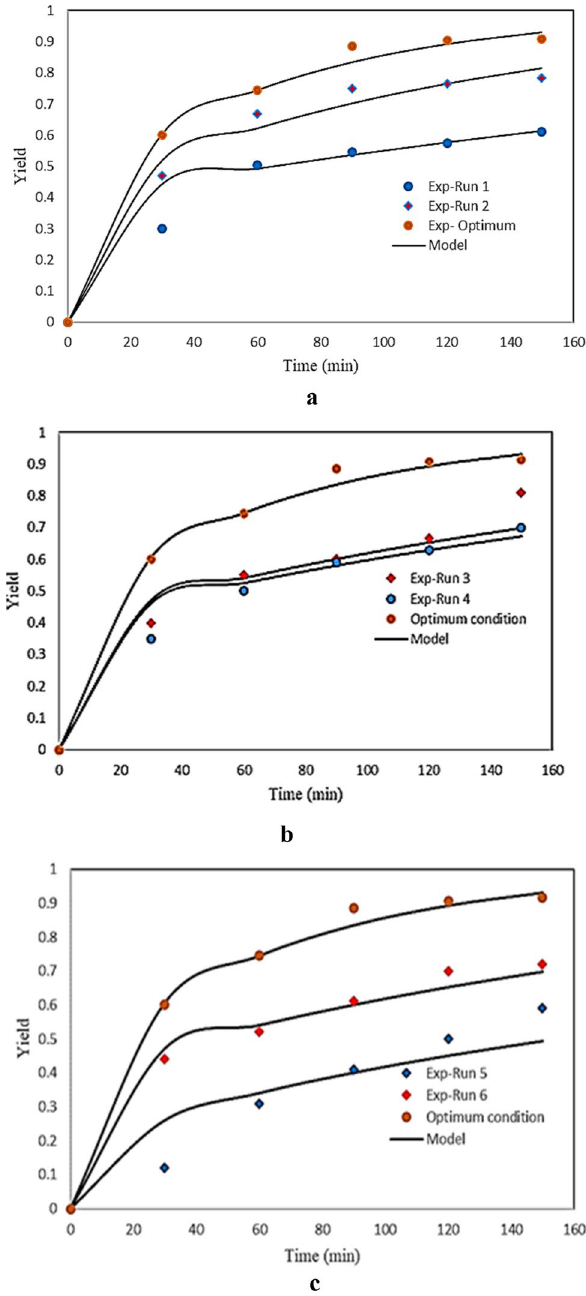
Figure 13. Effect of process parameters on the yield of extraction versus